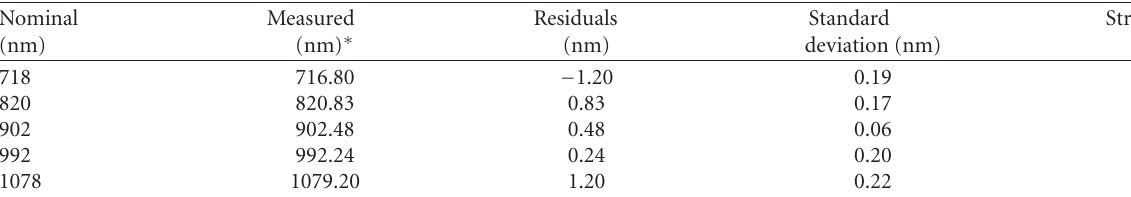
Table 1: Statistic result of the five tested wavelengths.